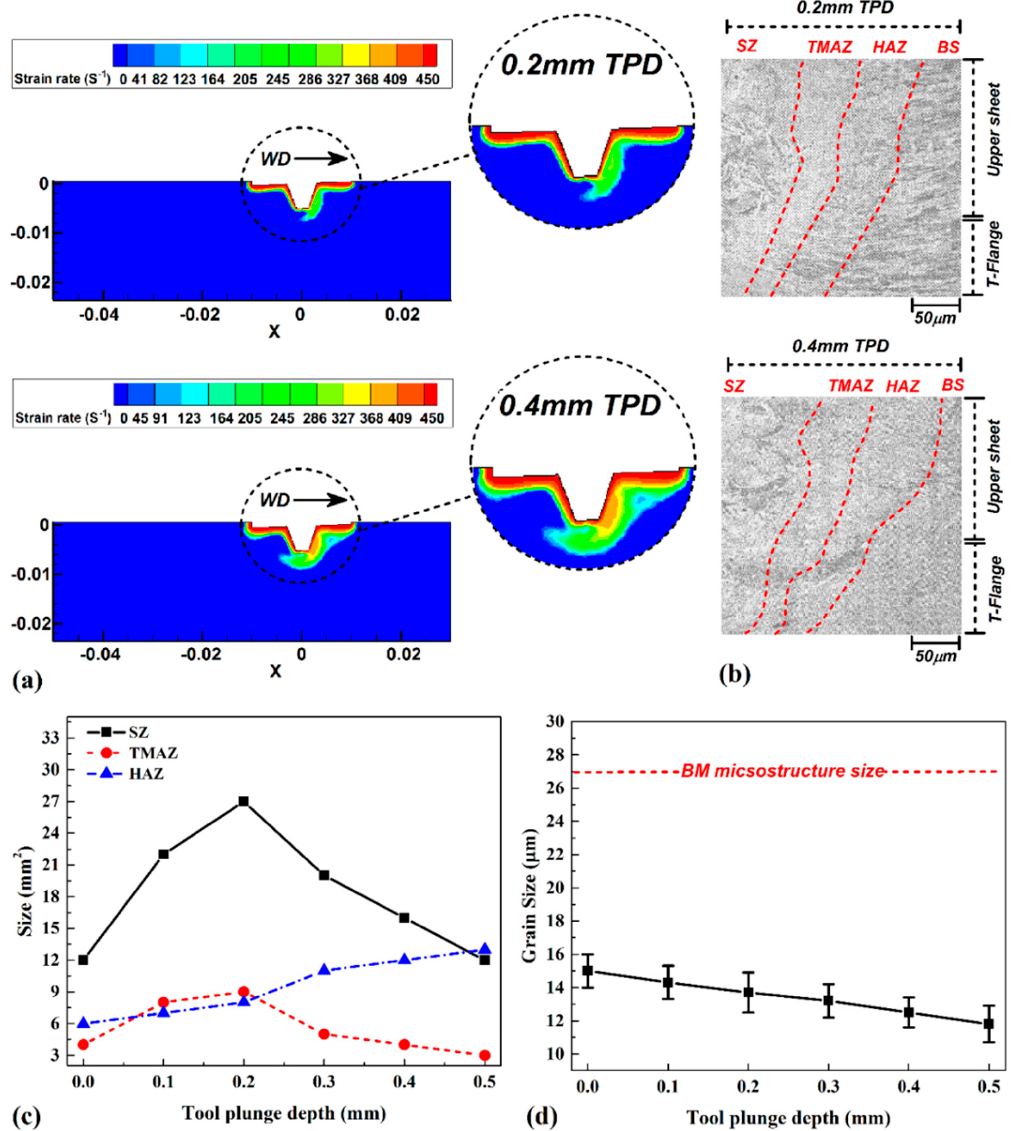
Figure 7. ( a ) Simulation results of strain rate in 0.2 mm and 0.4 mm TPD joints. ( b ) Microstructure of SZ in 0.2 mm and 0.4 mm TPD joints. Statistic results of ( c ) joint size and ( d ) grain size in skin and flange at different cases.